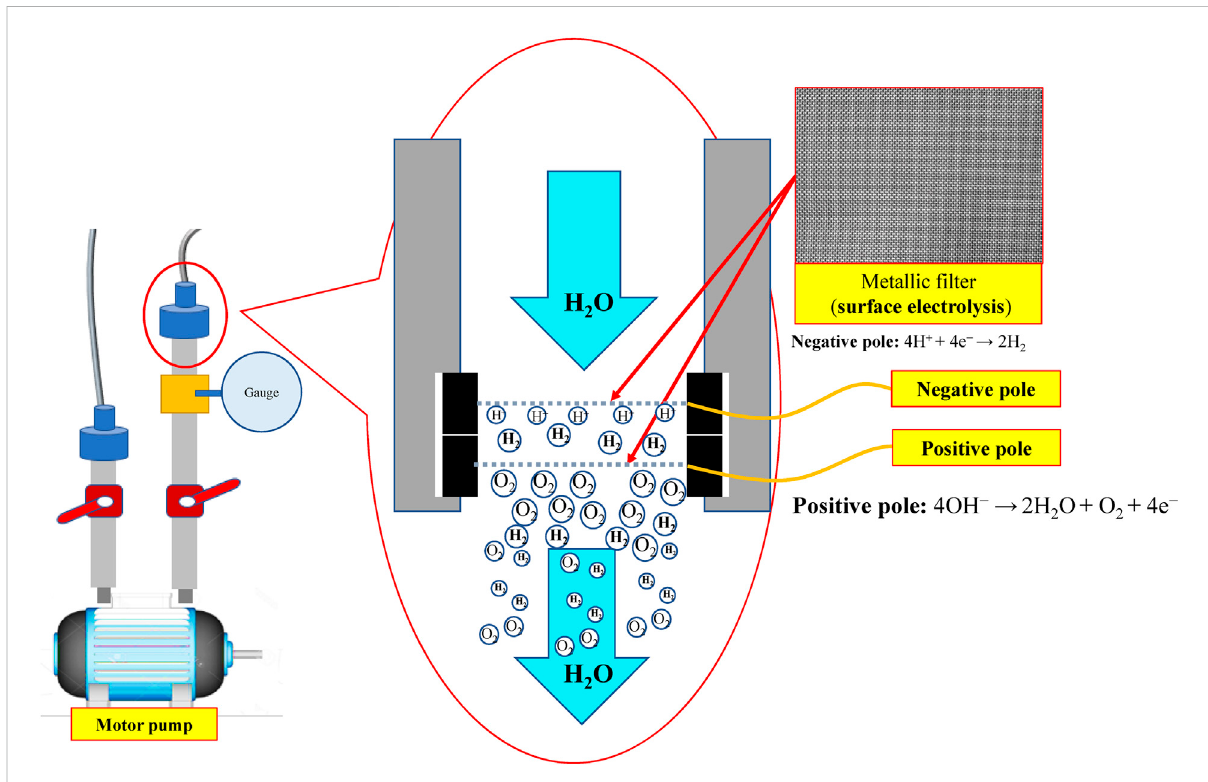
FIGURE 1 Structural system schematic diagram for electrolytic nano H 2 /O 2 bubble generating